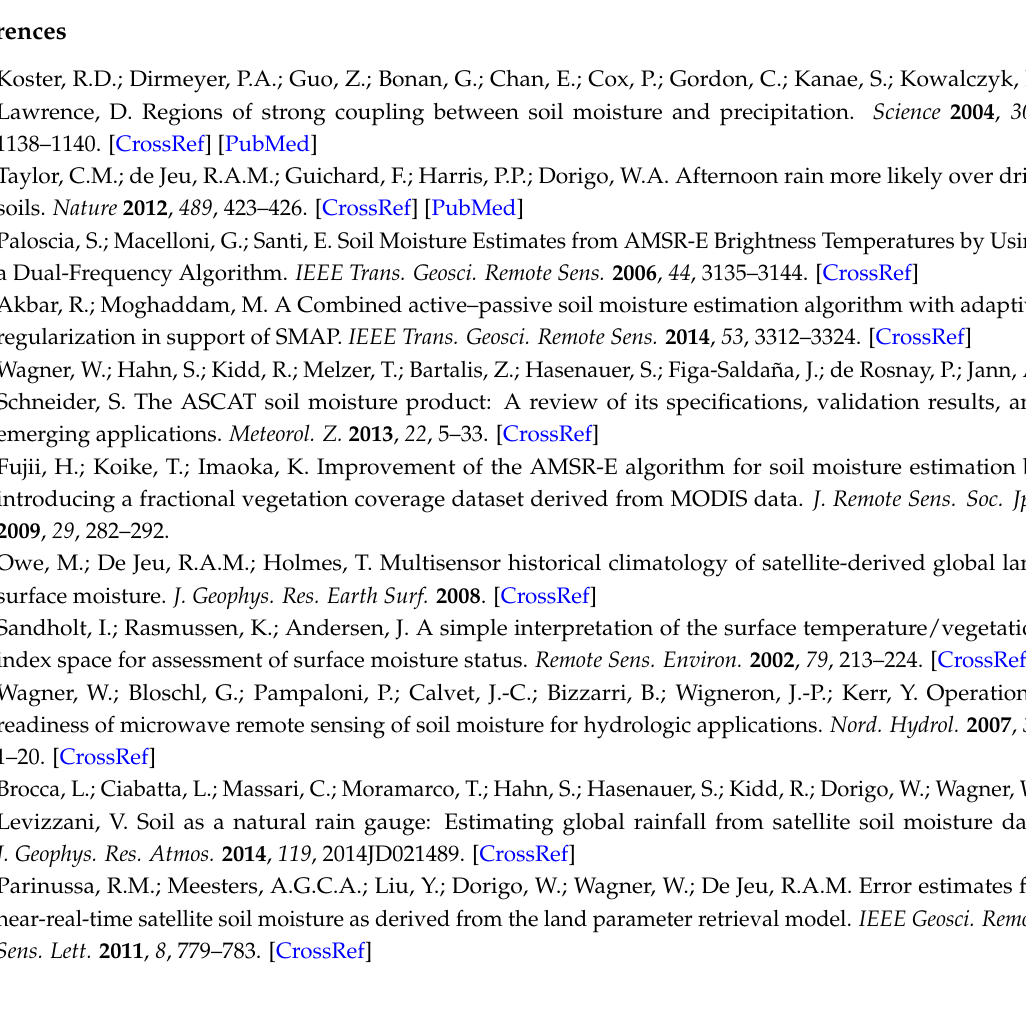
Figure S1: Results from experiments that uses MERRA-Land as the reference for various window sizes (N60, N90 and N120). Each panel shows the R between the reference and (a) JAXA; (b) LPRM; (c) static; (d) N60; (e) N90 and (f) N120. The more bluish colors in the maps indicate higher R against the reference, the overall performance for the various scenarios is summarized in a boxplot (g). Figure S2: Differences in R between the static and dynamic products (N90 and N120). For ERA-Interim as the reference, (a) R of N90 minus R of static and (b) R of N120 minus R of static. (c) and (d) show corresponding results with (a) and (b) when using MERRA-Land as the reference. With relation to Figure 4a in the main manuscript, it is shown that the differences are more contrasted with shorter N sizes. Figure S3: Mean weights used for dynamically combined soil moisture products. For ERA-Interim as the reference, (a) presents mean weights from N90 over the 2-year study period, and (b) from N120. (c) and (d) show corresponding results with (a) and (b) when using MERRA-Land as the reference. Figure S4: Standard deviations of optimal weights used for dynamically combined soil moisture products. For ERA-Interim as the reference, (a) presents standard deviations from N60 over the 2-year study period, (b) from N90, and (c) N120. (d), (e) and (f) show corresponding results with (a), (b) and (c) when using MERRA-Land as the